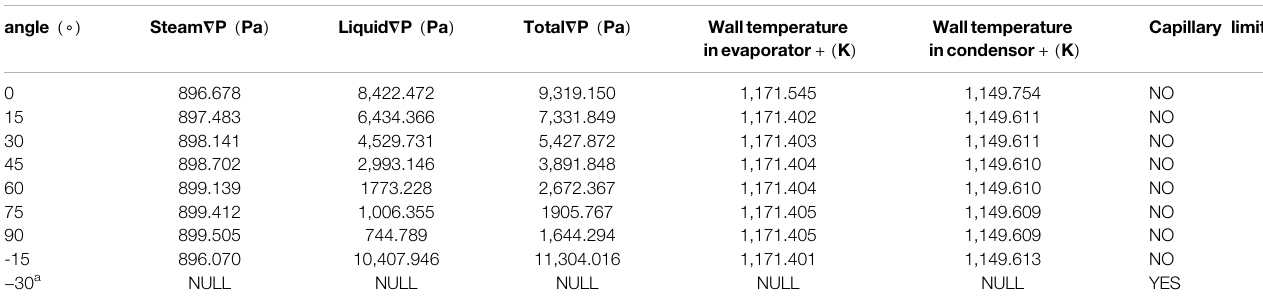
Walltemperature inevaporator + ( K ) incondensor + ( K